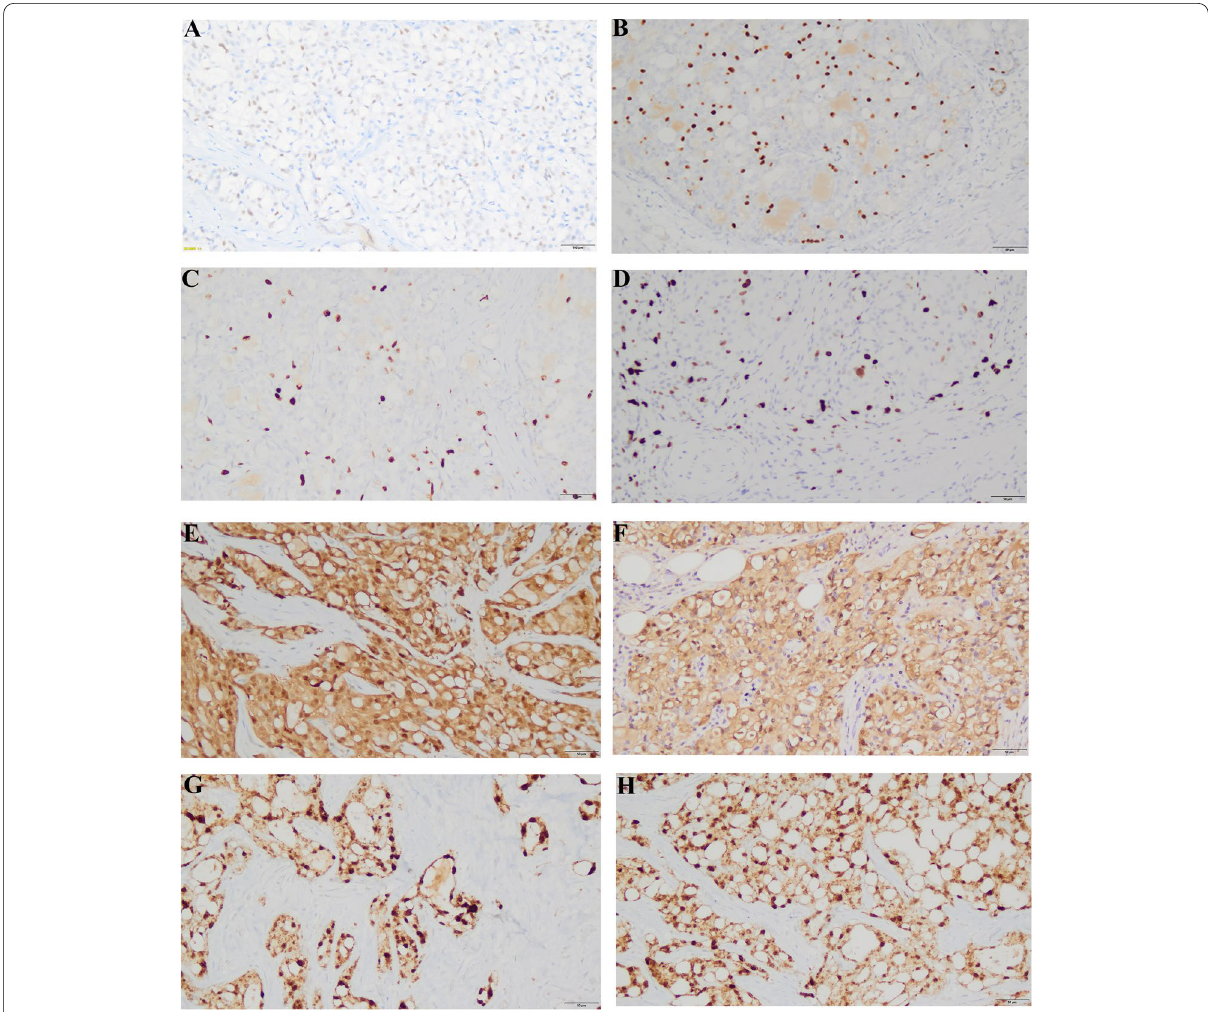
Fig. 2 Immunohistochemistry staining of SBC. A Weak positive ER staining. B Moderate to strong positive ER staining. C Relatively low Ki-67 index/ immunoreactivity. D Relatively high Ki-67 index/immunoreactivity. E , F Diffuse and strong S-100 immunoreactivity. G , H Strong positive nuclear staining for Pan-TRK in all cases